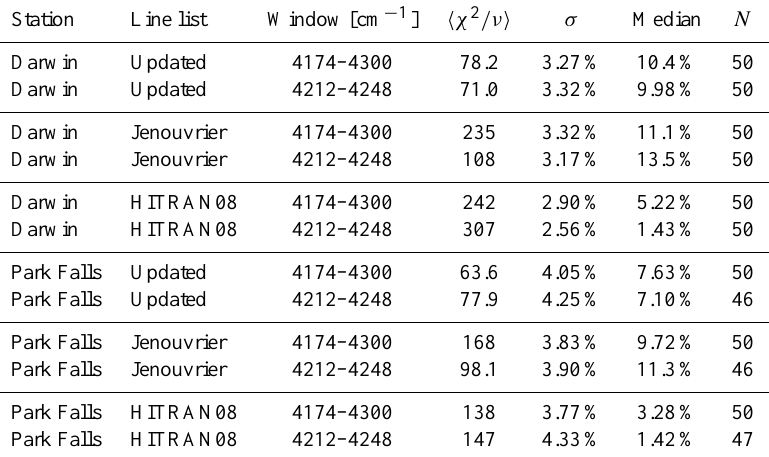
Table 1. Statistics of the differences in fitted H 2 O columns between our retrievals for two different windows in the 2.3µm range using different line lists, and retrievals from TCCON’s GFIT algorithm at 1.6µm. Our updated spectroscopy leads to a clear reduction of the average reduced χ 2 of the fit residuals, h χ 2 /ν i , both compared to the original Jenouvrier et al. (2007) line list and HITRAN08. The precision σ , i.e. the standard deviation around the mean relative difference, shows no improvement. The median is most robust against the change in the fitting window for the updated spectroscopy. The absolute value of the median (i.e. the bias) is not a very meaningful parameter as it depends on initial parameters and could easily be calibrated to zero. The last column shows the number of retrievals on which the statistics are based (if less than 50 then not all retrievals reached